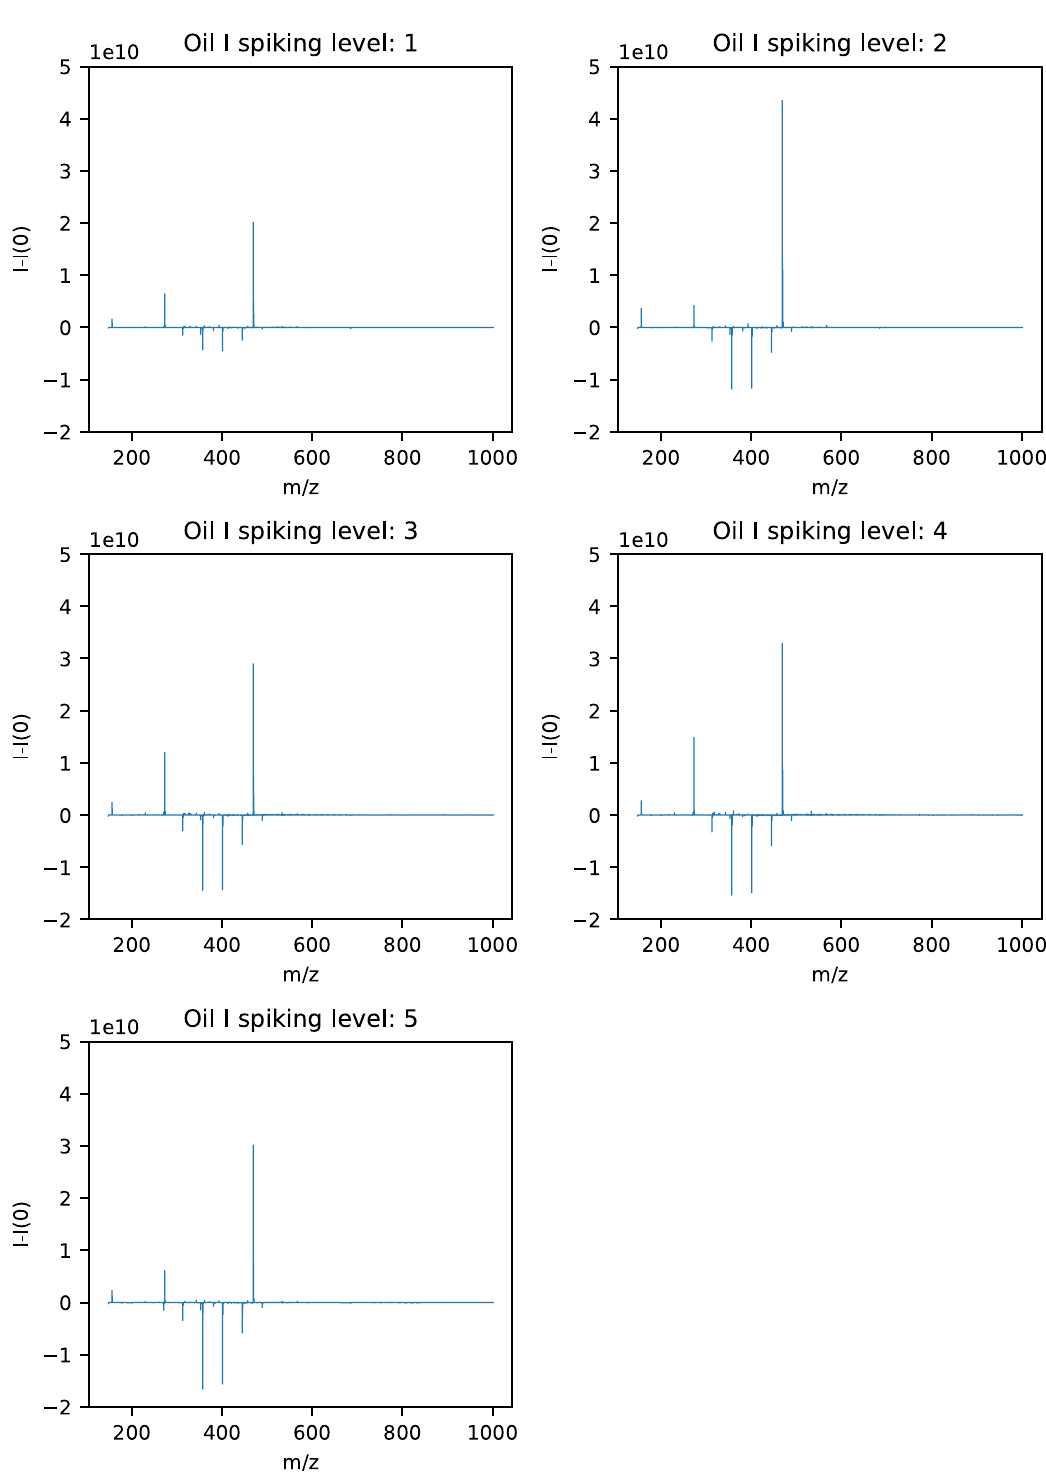
PLOS ONE | https://doi.org/10.1371/journal.pone.0273084 August 17,